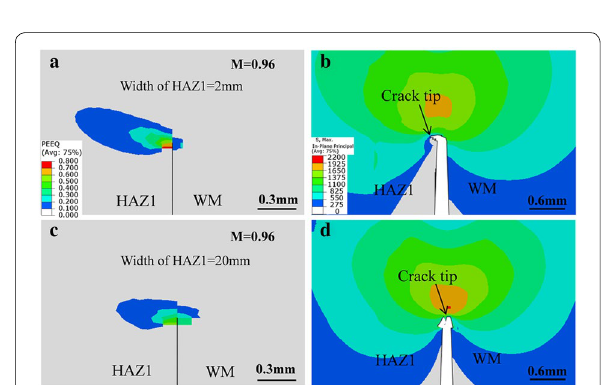
Figure 5 Distributions of strain and stress around crack tip for SENB with different HAZ widths: a , b HAZ1 width width 20 mm (Unit in b , d is =